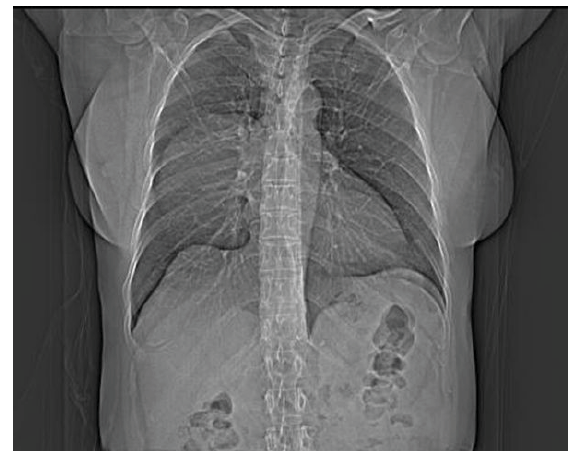
Figure 1. Chest X-ray shows large well defined mass in the right hemithorax.